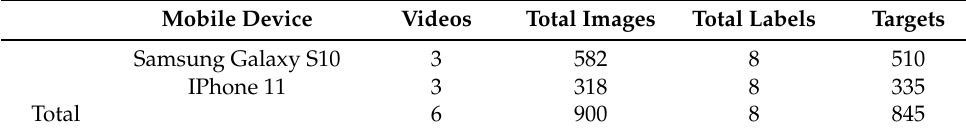
Table 2. Characteristics of the Datasets created for training and testing the object detector.